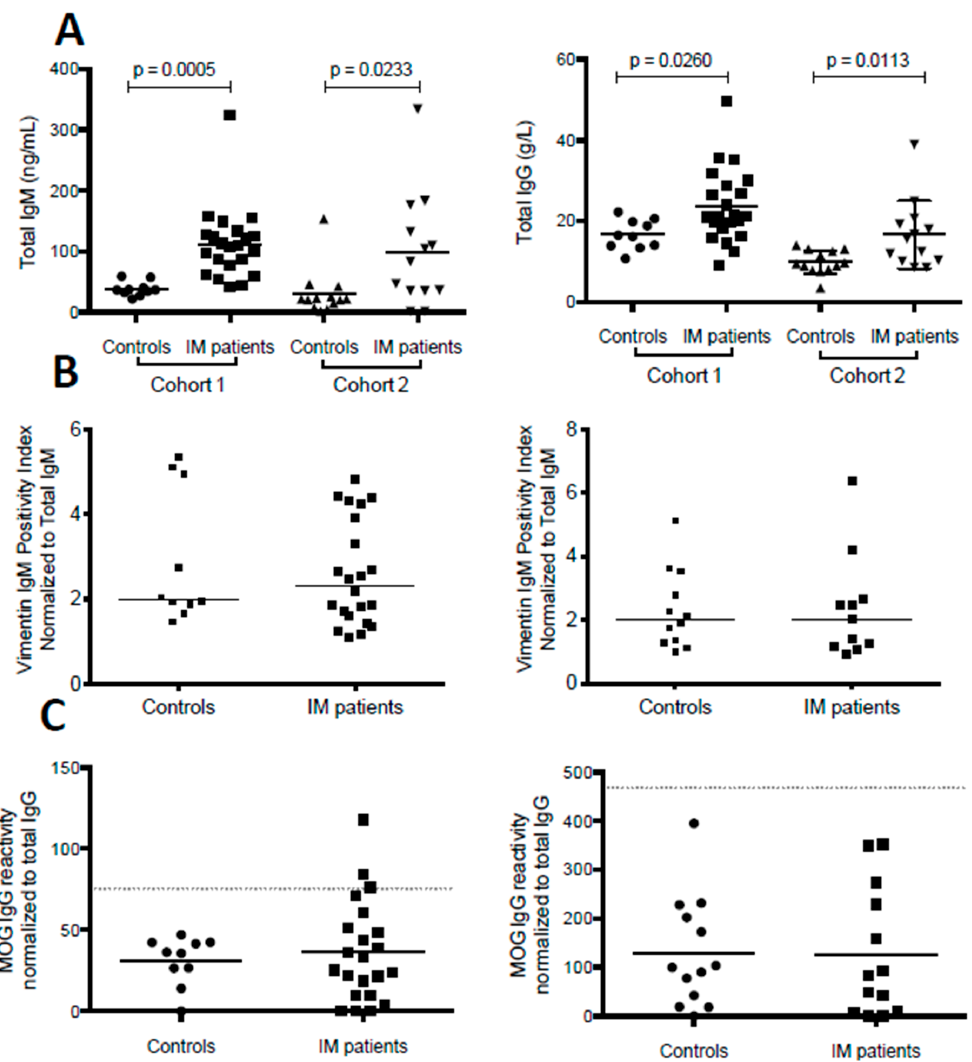
complete loss of significant differences for anti-vimentin IgM titers (Figure 3B). In contrast, anti-MOG specific IgG responses were still detectable in a subset of three out of 35 patients with IM (9%), even after normalization to total IgG levels (Figure 3C).